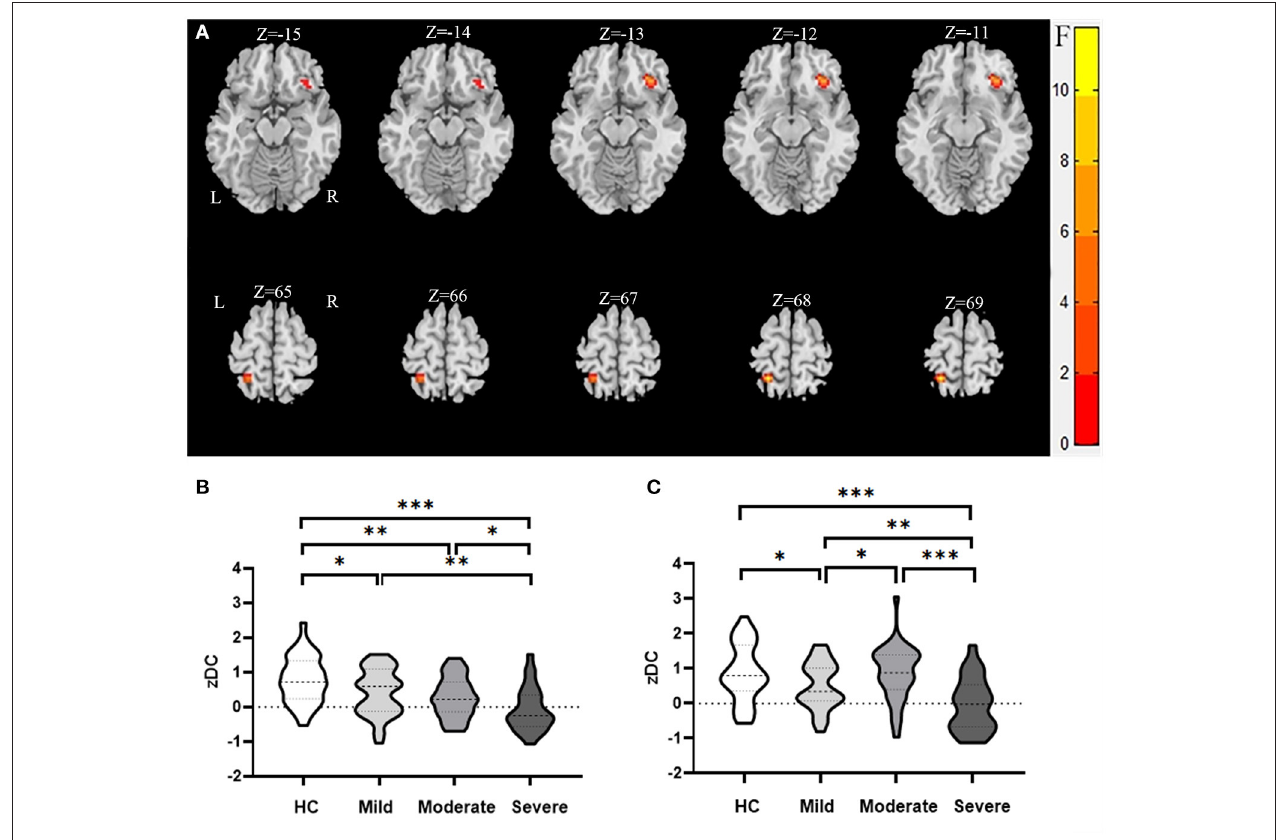
FIGURE 1 | Brain regions showing abnormal DC value in the WMHs compared to the HCs in MNI space. (A) Significant DC value differences were observed in the right inferior frontal orbital gyrus and the left superior parietal gyrus [ − 15, − 14, − 13, − 12, − 11, 65, 66, 67, 68, 69 in (A) are the coordinates of Z-axis in Montreal Neurological Institute space, and the unit of coordinate system is millimeter]. (B,C) Mean values of altered DC values in the right inferior frontal orbital gyrus and the left superior parietal gyrus between the HCs and WMHs groups. ***Significant at 0.001 level, **significant at 0.01 level, and *significant at 0.05 level (2-tailed).